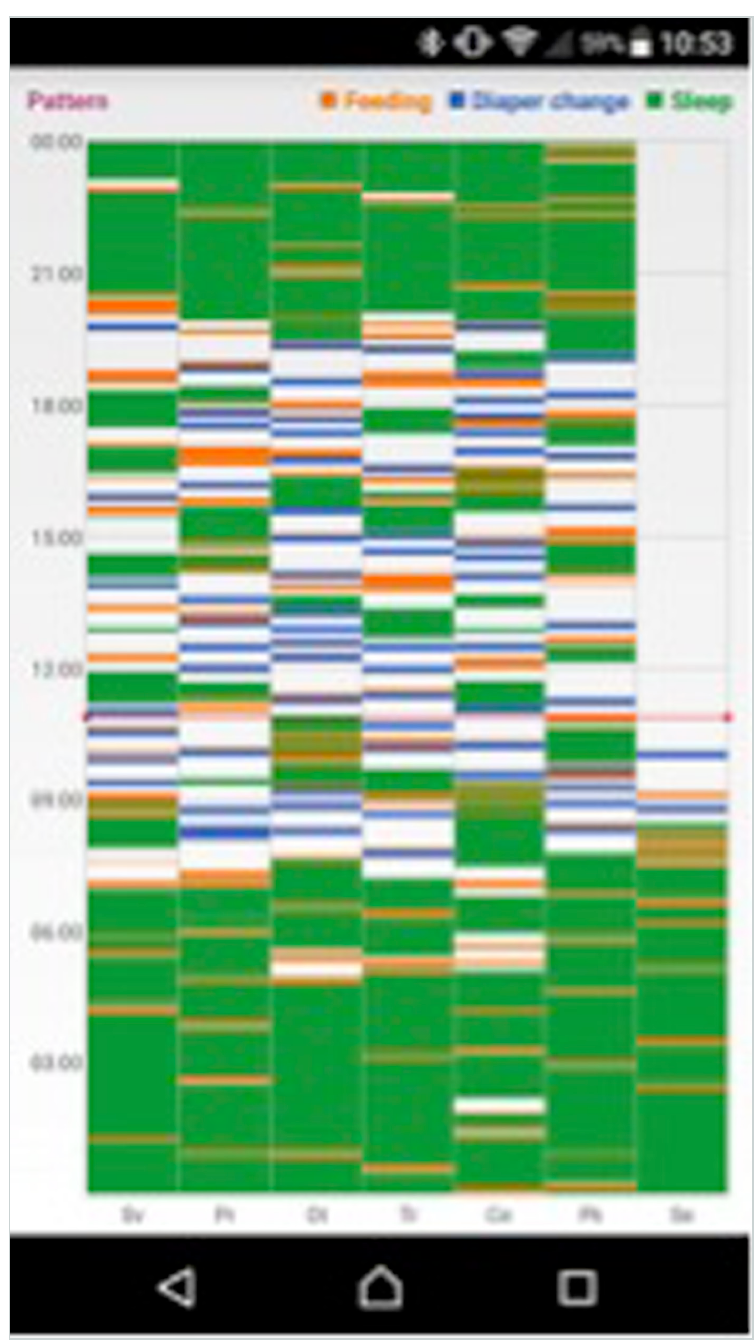
Figure 7: Maternal workload